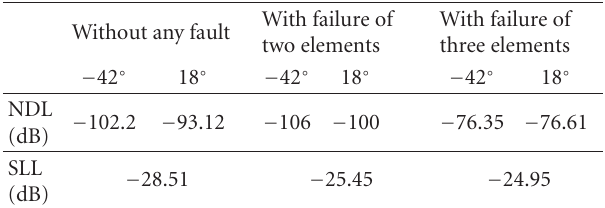
Figure 12: Radiation pattern for 3rd, and 18th element failure with main beam at broadside and nulls at − 20 ◦ , 33 ◦ and 50 ◦ . Dotted line curve shows the damaged array pattern and the solid line curve shows the corrected pattern. Table 4: Comparison of NDL and SLL for the configurations dis- cussed in Case 2.